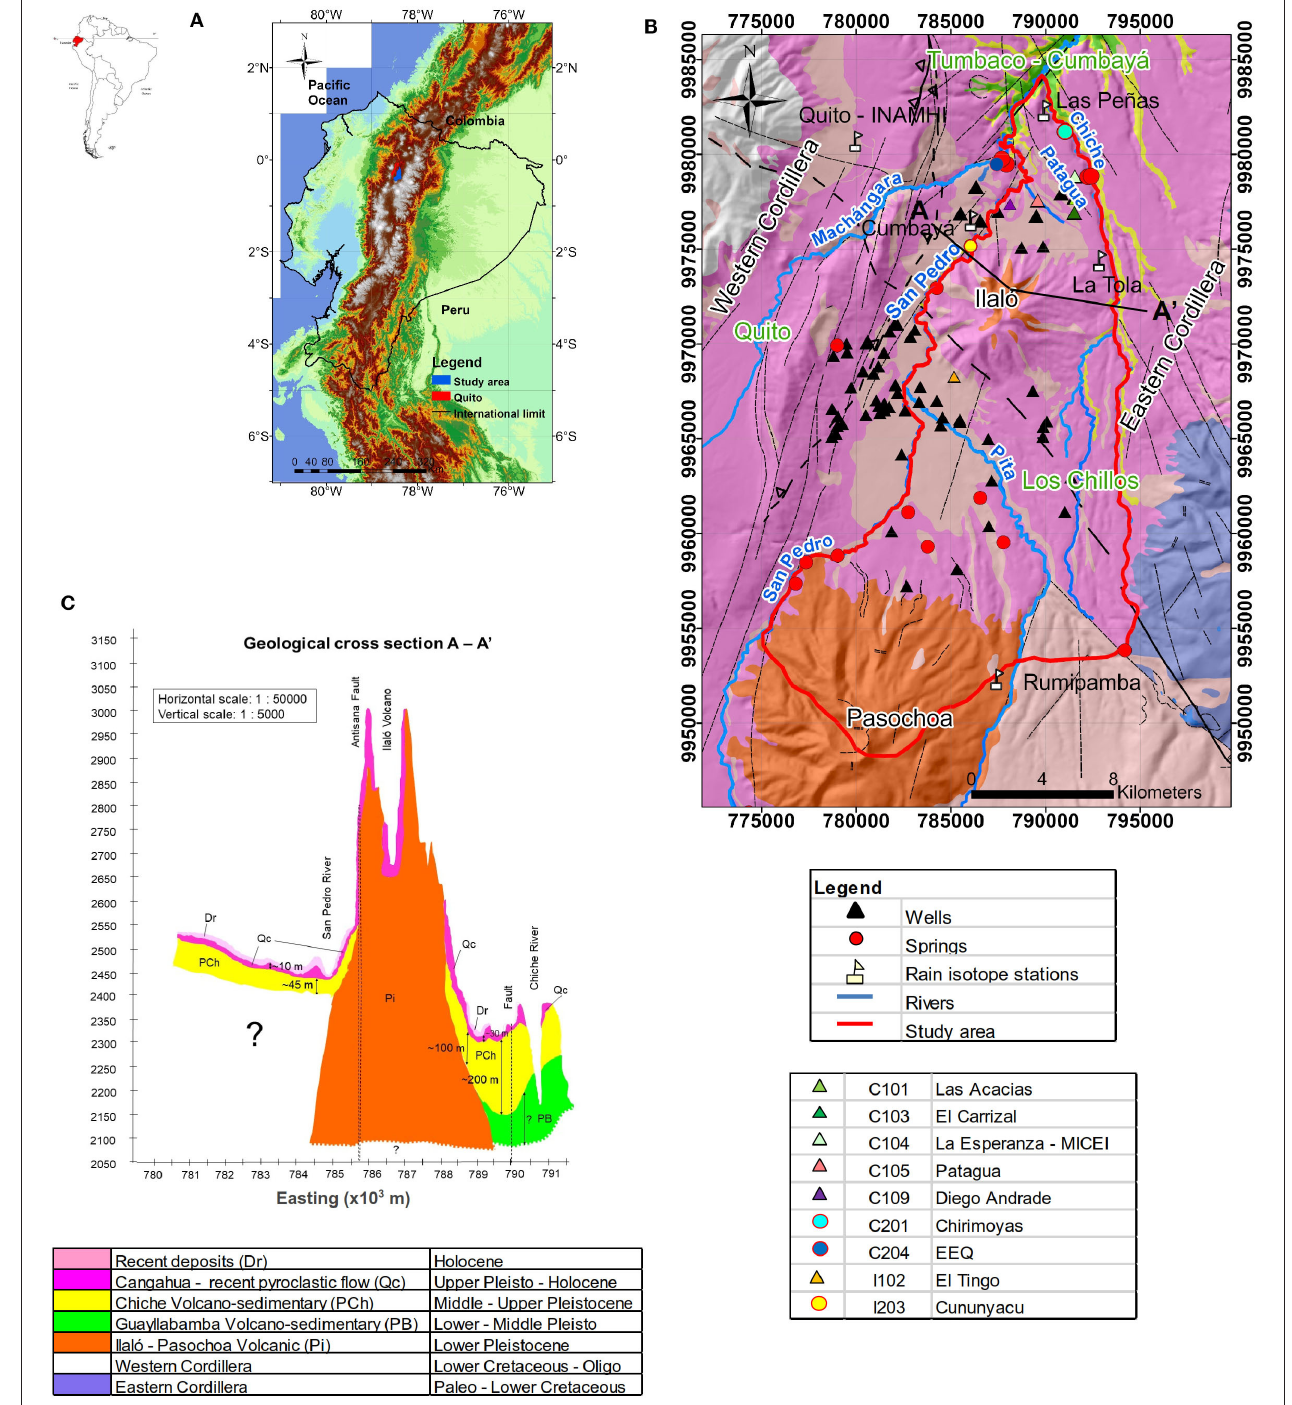
FIGURE 1 | Study area and geological settings. (A) General map of Ecuador. (B) Geological map of the study area. (C) Geological cross-section along AA’. NE-SW and NW-SE are the preferential directions of fractures.